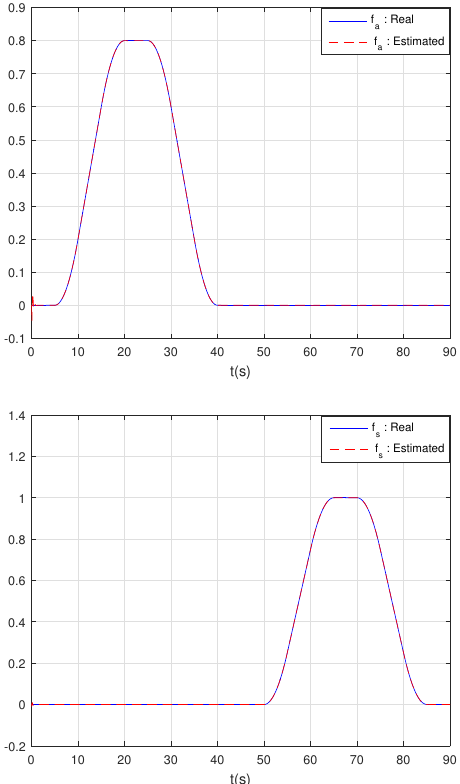
Figure 4. f a and f s with their